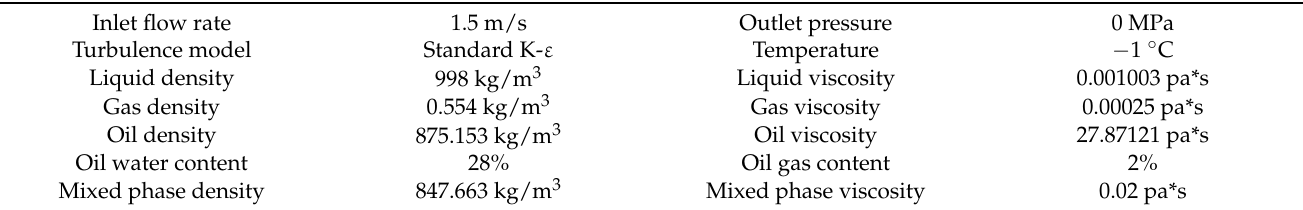
Table 2. The boundary conditions of the simulation